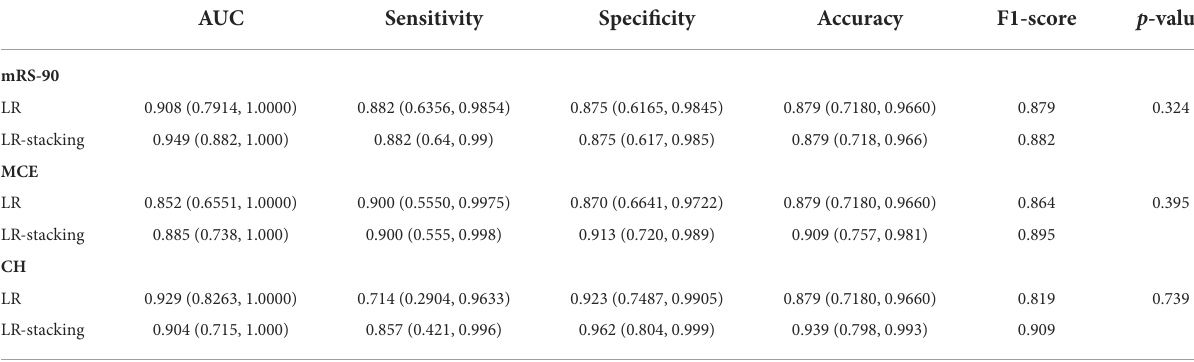
TABLE 3 The AUC, sensitivity, specificity, accuracy, and F1-score comparisons of generalized LR and LR-Stacking method.